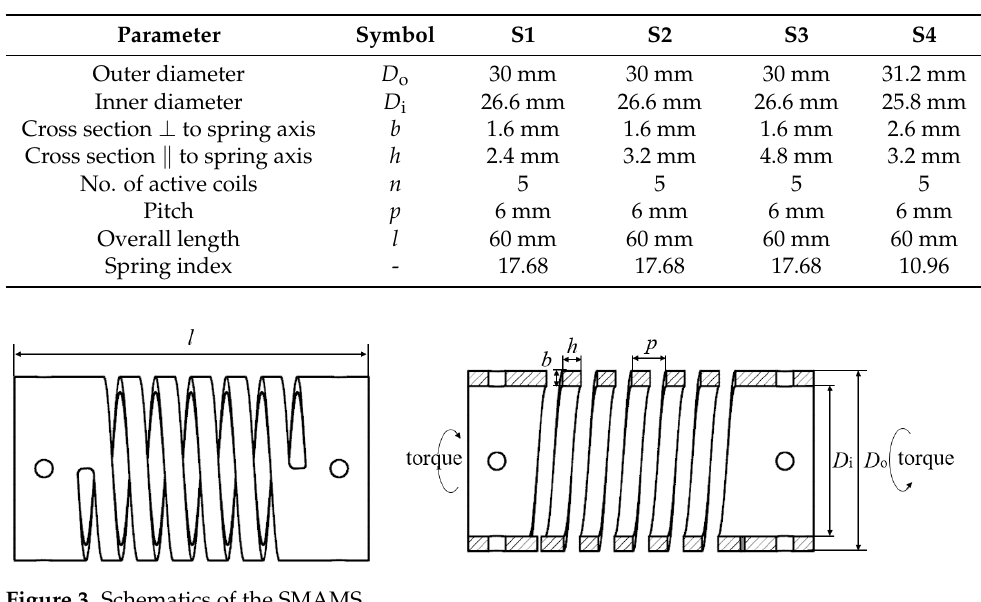
Table 2. Geometric parameters.